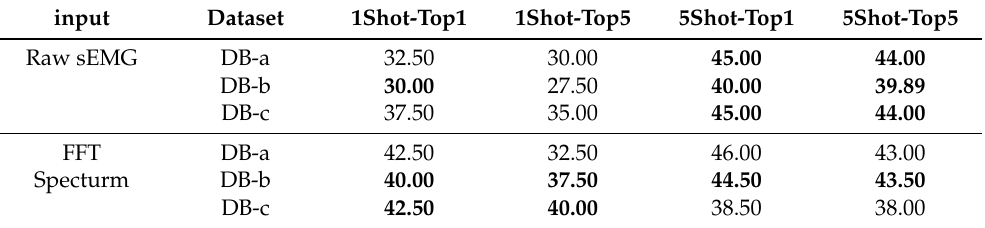
Table 6. 5-way 1-shot and 5-way 5-shot classification top 1 and top 5 accuracy (%) of different input forms for new subject on CapgMyo with MAML. The meta batch size is set to 8. The boldface numbers represent the best classification accuracies for each input and dataset compared with Table 7.